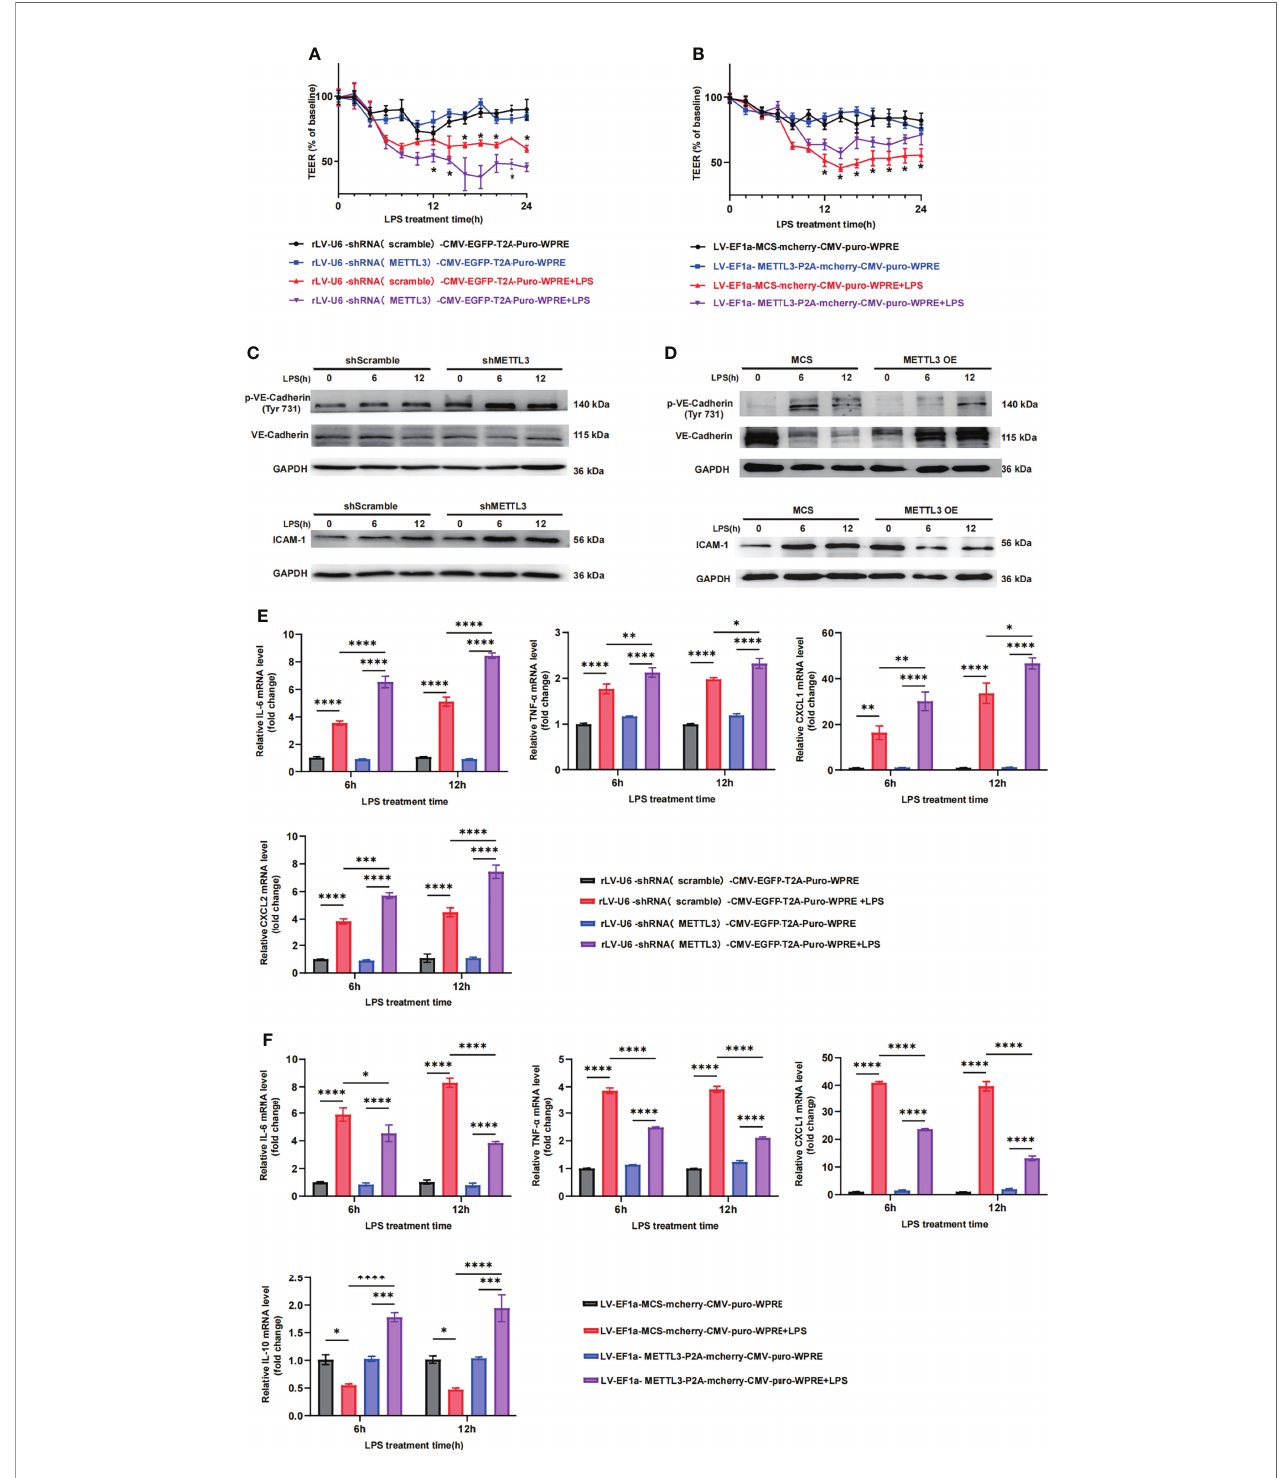
FIGURE 3 | METTL3 regulates vascular endothelial barrier function in vitro. (A, B) TEER was used to measure endothelial permeability in HULEC-5a cells transfected with scramble or METTL3 shRNA (A) and in HULEC-5a cells with or without METTL3 overexpression (B) . (C, D) Immunoblot showing the protein expression of VE-Cadherin and ICAM-1 in HULEC-5a cells transfected with scramble or METTL3 shRNA (C) and in HULEC-5a cells with or without METTL3 overexpression (D) . (E, F) RT-qPCR analysis showing in fl ammatory cytokine mRNA expression in HULEC-5a cells transfected with scramble or METTL3 shRNA (E) and in HULEC-5a cells with or without METTL3 overexpression (F) . All data are expressed as the mean ± SD of three independent experiments. * p < 0.05; ** p < 0.01; *** p < 0.001; **** p <